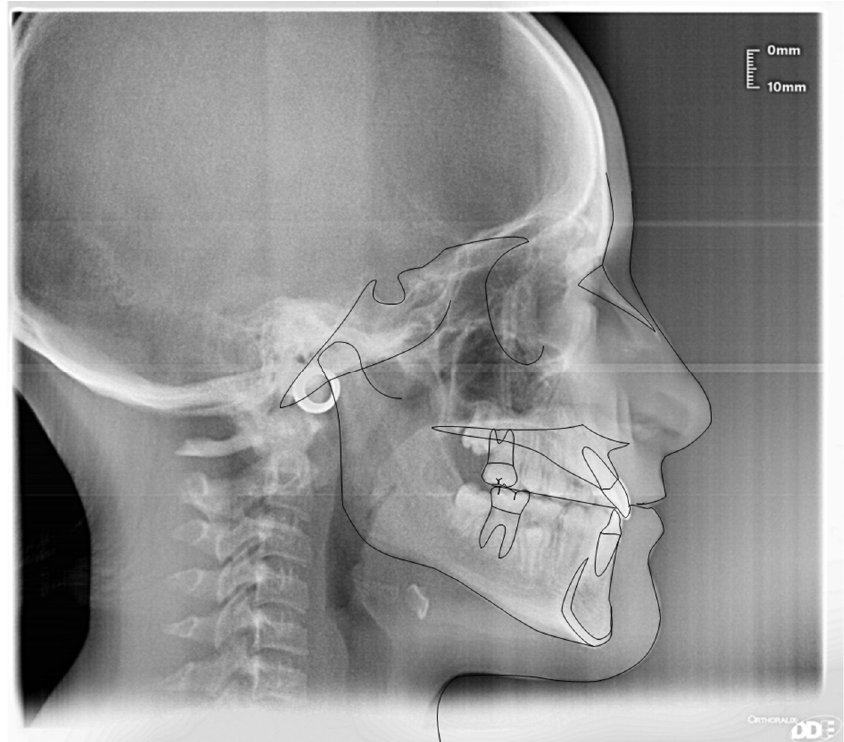
Figure 19. Radiographs of the subject at the end of the treatment. Orthopantomography X-ray after treatment (8-year-old).